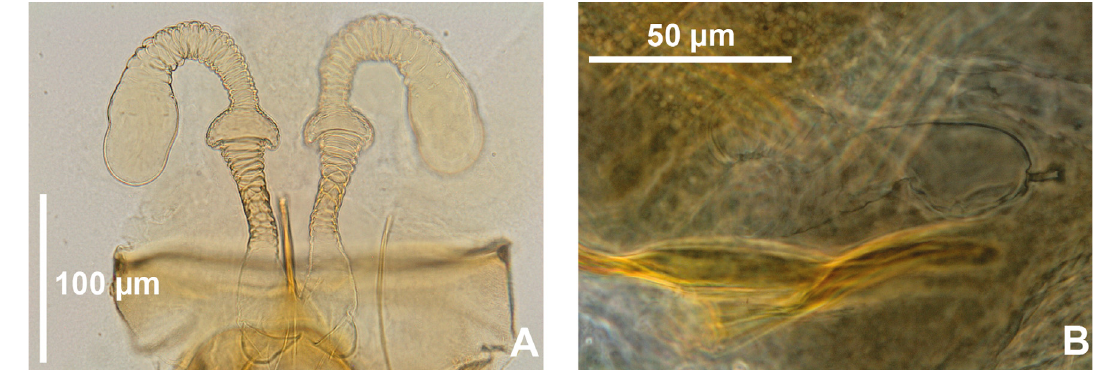
Figure 2. Spermathecae of Spelaeomyia mirabilis (A) and Parvidens heischi